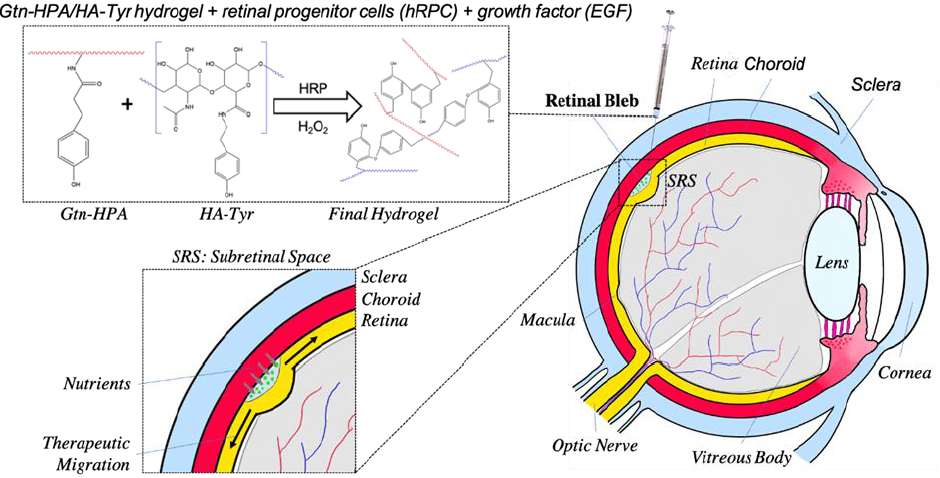
Figure 1. Schematic of the proposed therapeutic approach using hydrogels for retinal regeneration. Retinal progenitor cells (hRPCs) and growth factor (EGF) are mixed with liquid solutions of Gtn-HPA and HA-Tyr. As soon as the catalyst (HRP) and crosslinker (H 2 O 2 ) are added, the final therapeutic is injected into the subretinal space through the sclera and the retina with a 31-gauge needle. This creates a retinal bleb, which contains the final solid hydrogel encapsulating cells and growth factors. This therapeutic then migrates along the retina, releasing cells to engraft in the host